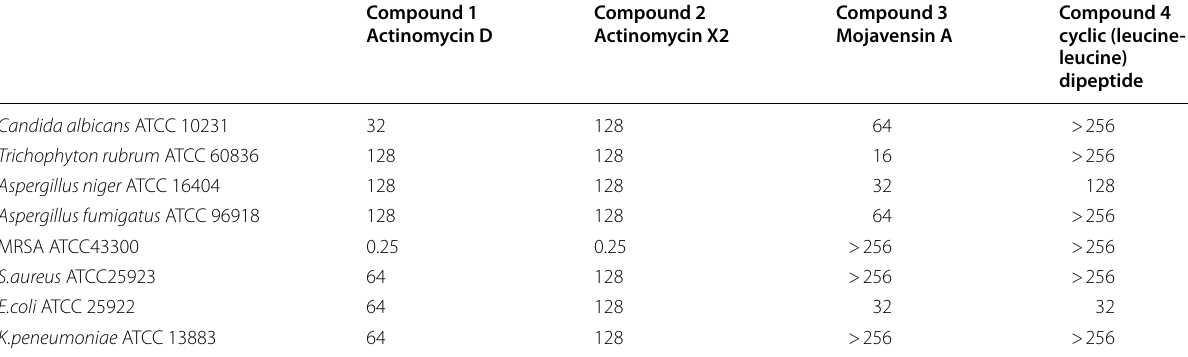
Table 2 The Minimal inhibitory concentration (MIC) of Compounds against the tested strains (μg/mL)